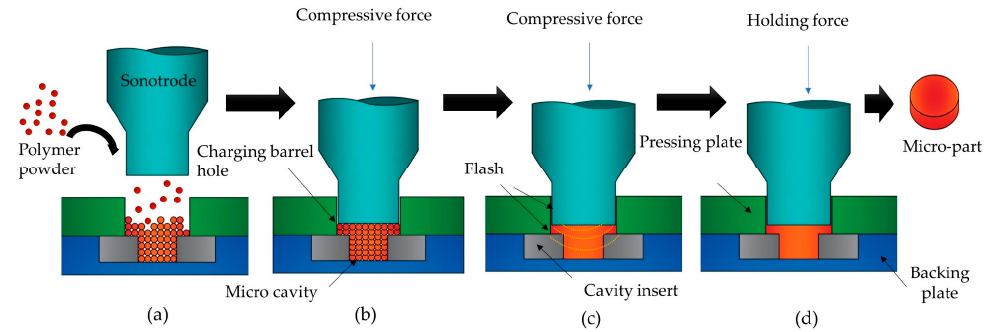
Figure 3. Schematic representation of the ultrasonic compression molding. ( a ) Sonotrode positioning and cavity filling; ( b ) compacting polymer powder; ( c ) ultrasonic plasticization; ( d ) cooling, release and flash peel. Adapted from Reference [25].